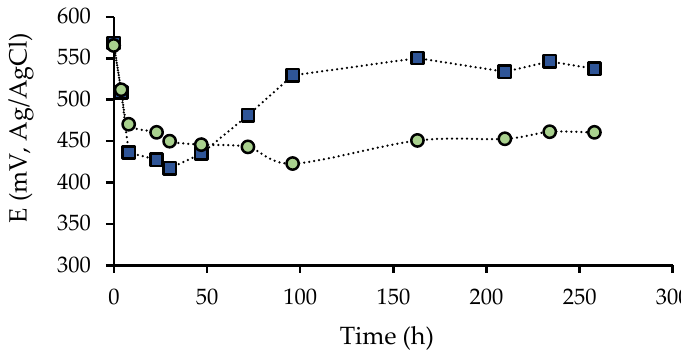
Figure 4. Evolution of the redox potential during the two-step leaching experiment in the biotic (blue square) and abiotic (green circle) media when using biogenic Fe 3+ as the leaching agent.